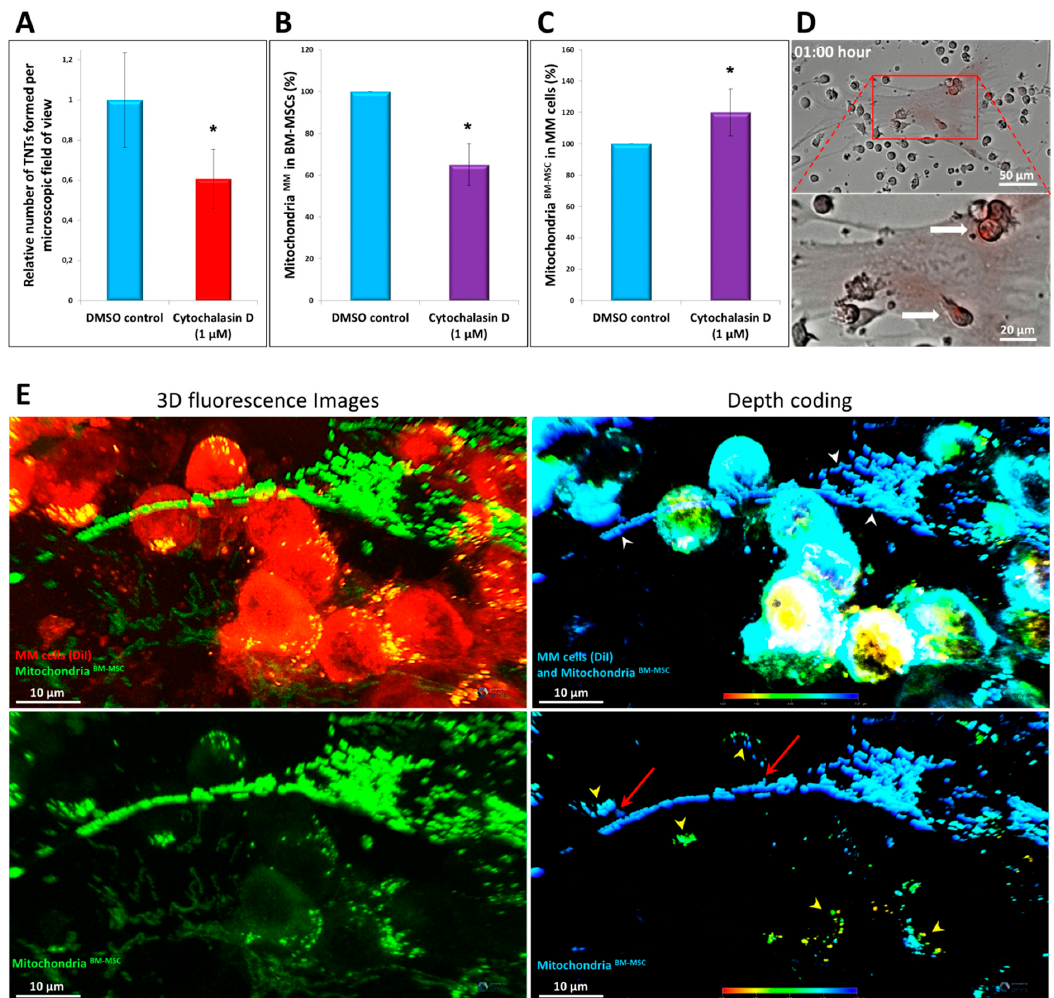
Figure 7. High-resolution 3D analysis of mitochondrial transfer using confocal laser scanning microscopy and the effect of cytochalasin D on mitochondrial transfer and TNT formation. BM-MSCs were labeled with MitoTracker Red FM ( A – D ); BM-MSCs were expressing mitochondrial-targeted AcGFP1 fluorescence protein ( E ). MMs were unlabeled ( B , C ) or were labeled with Vybrant DiI membrane-labeling dye ( A , E ). The cells were kept in co-cultures for 1 h ( D ) or 24 h ( A – C , E ) in the presence ( A – C ) or absence ( D , E ) of cytochalasin D. Mitochondrial transfer from BM-MSC to MMs was evaluated with a high-content screening method ( D ), flow cytometry ( B , C ), or confocal scanning microscopy ( A , E ), respectively. ( A ) BM-MSCs (labeled with MitoTracker Red FM) and MMs (labeled with Vybrant DiI) were co-cultured in the absence (DMSO control) or presence